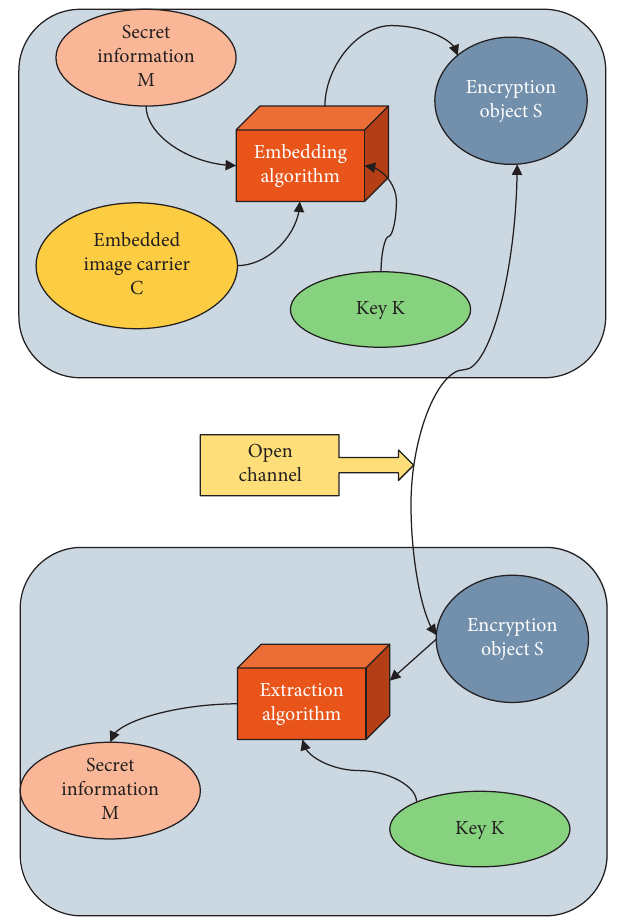
Figure 3: Classic model of steganography